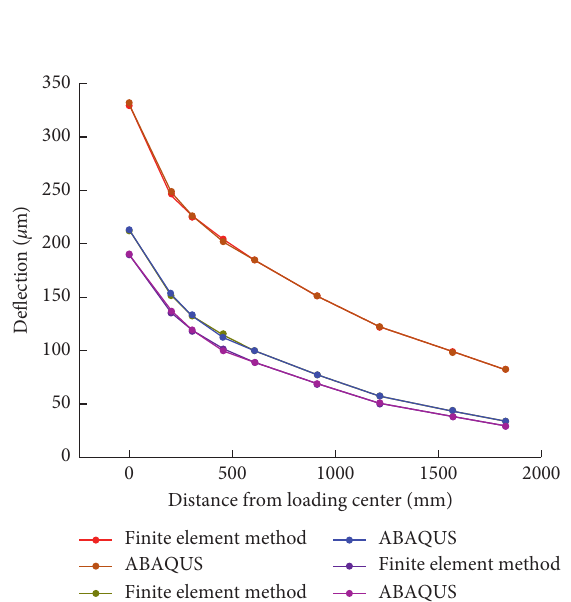
Figure 3: Finite element model.